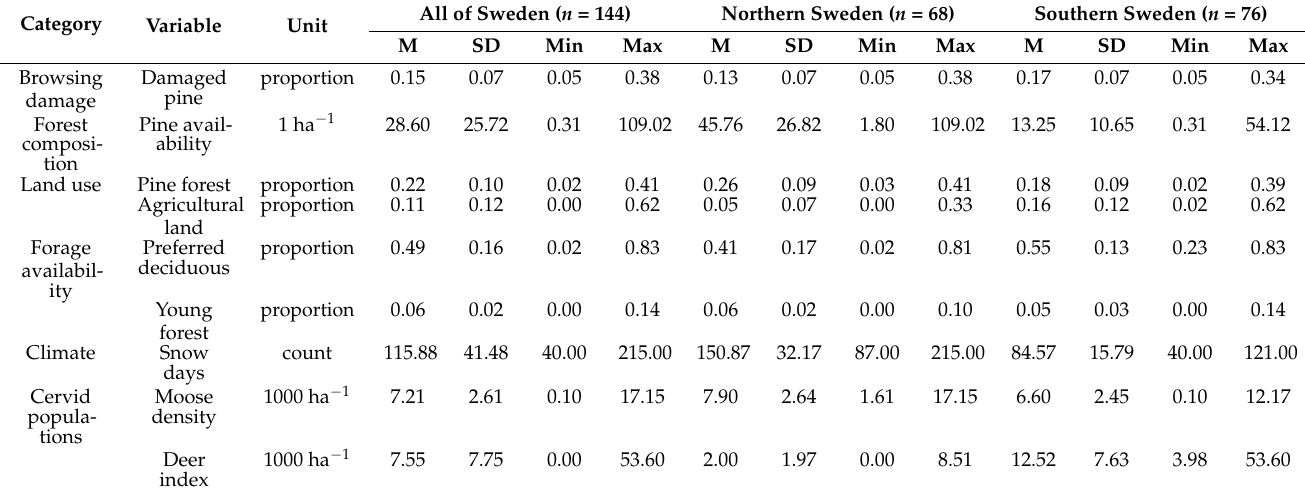
Table 2. Summary of variables used in the path analysis, including their sample size ( n ), mean value (M), standard deviation (SD) and range (Min–Max) within the complete dataset for the national model and the respective samples for the northern and southern Sweden